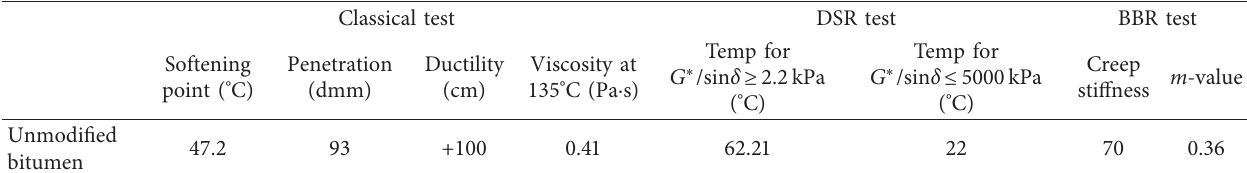
Table 1: Characteristics of unmodified